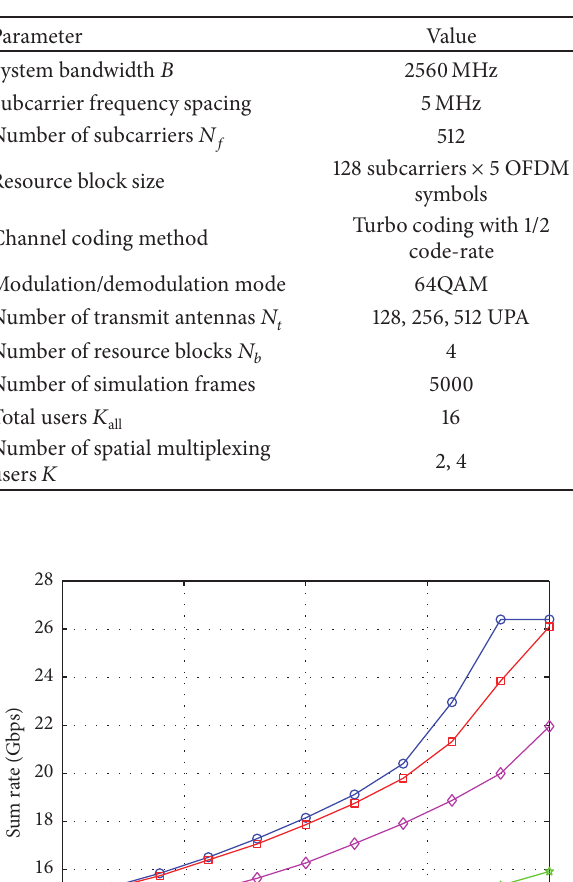
Table 1: Simulation parameter.